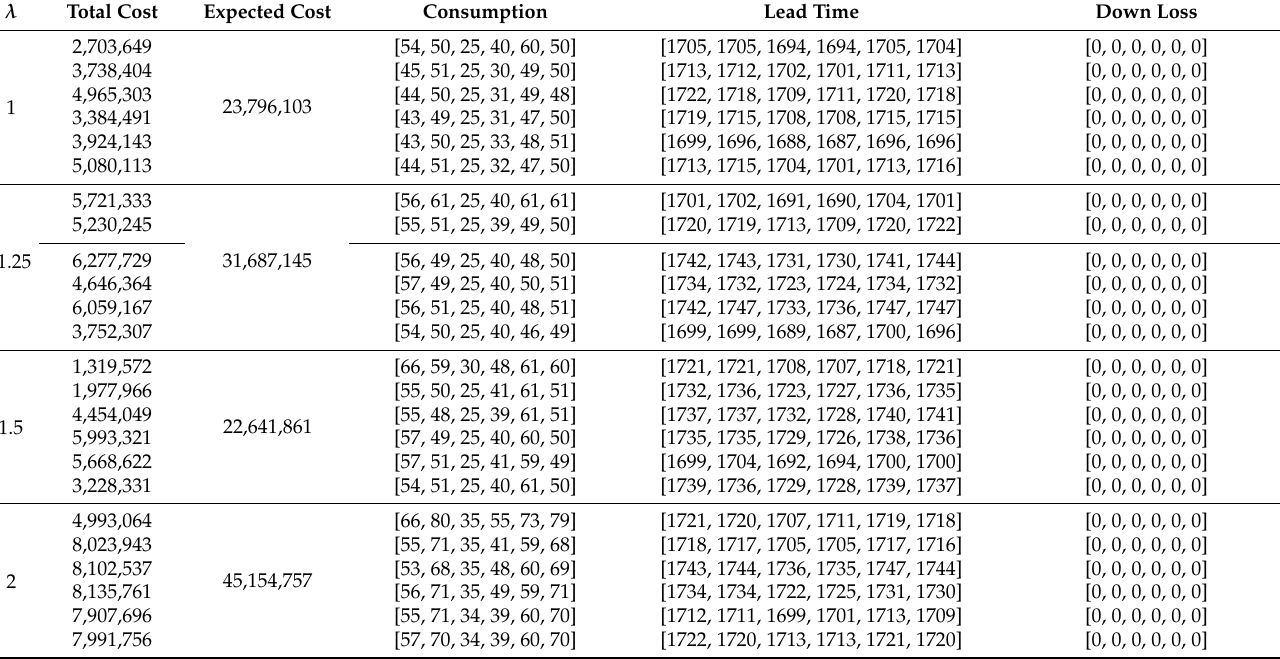
Table A5. Results for different equipment failure